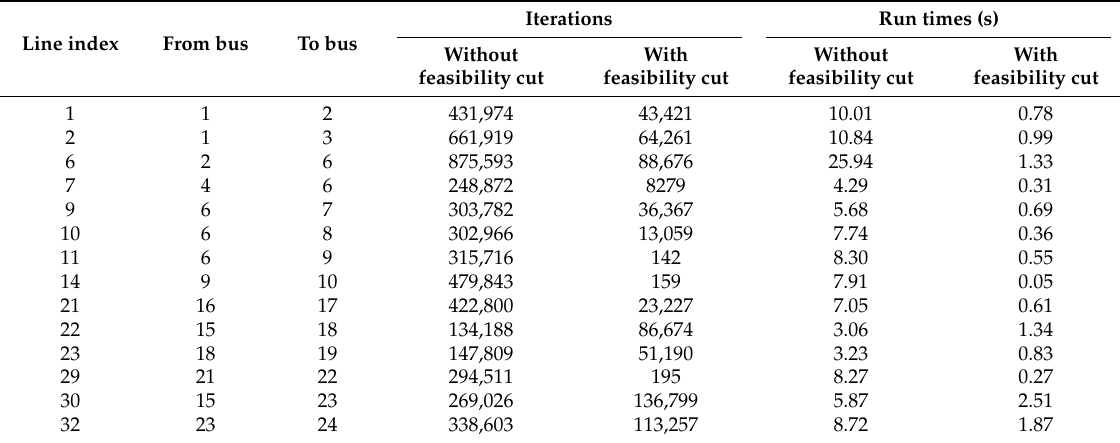
Table 2. Impact of the feasibility cut acceleration technique.